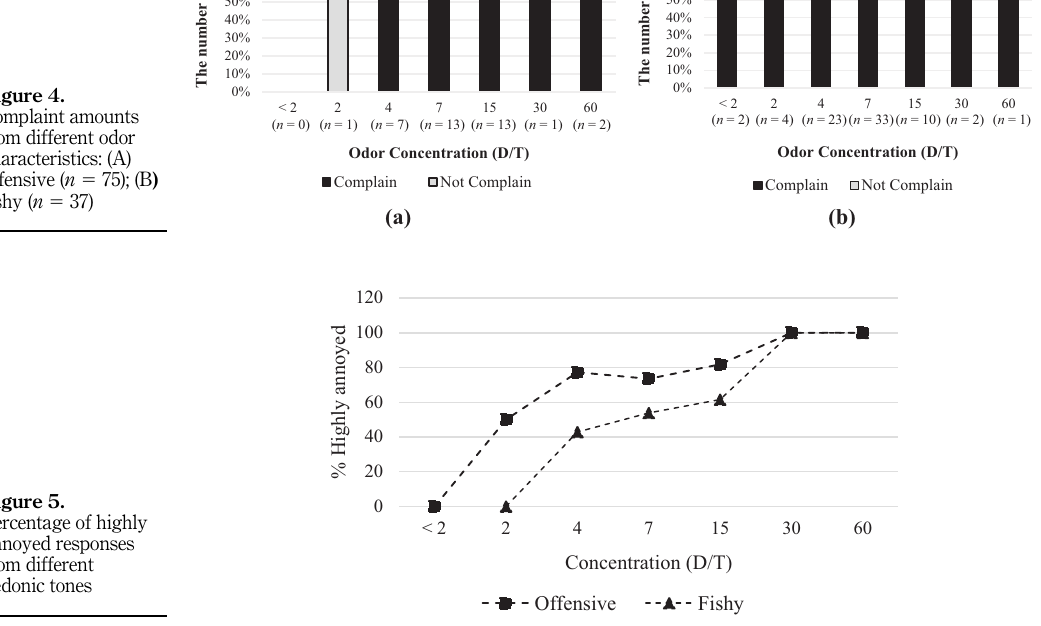
Figure 4. Complaint amounts from different odor characteristics: (A) offensive ( n 5 75); (B ) fishy ( n 5 37)